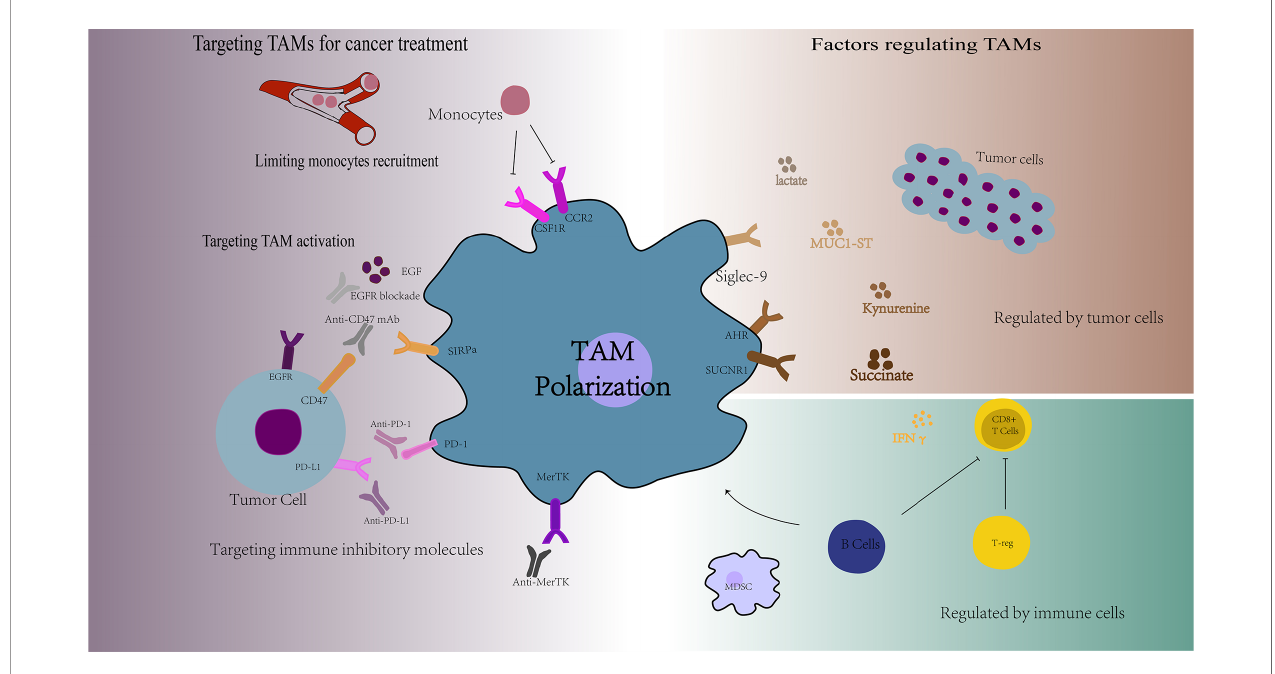
FIGURE 2 | Overview of the factors regulating TAMs functions and the targets of TAMs for cancer treatment. TAMs are a collection of multiple cell types with a wide range of functional effects, which are regulated by many different factors, such as the tumor cell-derived soluble molecules, tumor metabolic alterations, and other immune cells. Targeting TAMs is a new cancer treatment strategy, including limiting monocytes recruitment, targeting TAMs activation, and targeting TAMs speci fi c markers. AHR, aromatic hydrocarbon receptor; SUCNR1, succinate Receptor 1; EGF, epidermal cell growth factor; SIRP a , signal regulatory protein